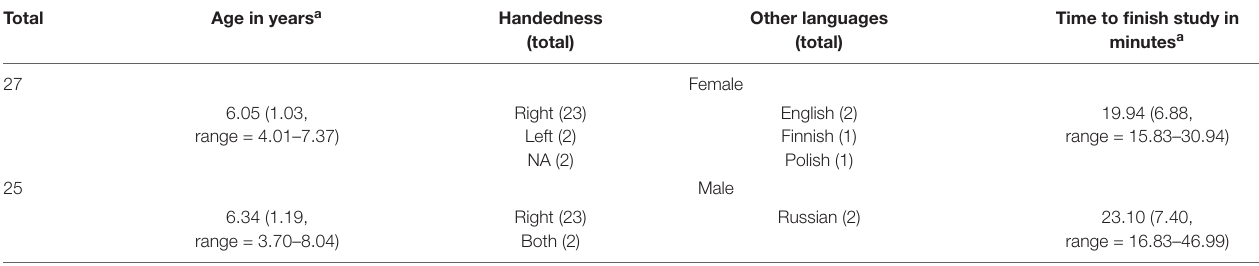
TABLE 1 | Summary of participants’ characteristics that were included in the data analysis.